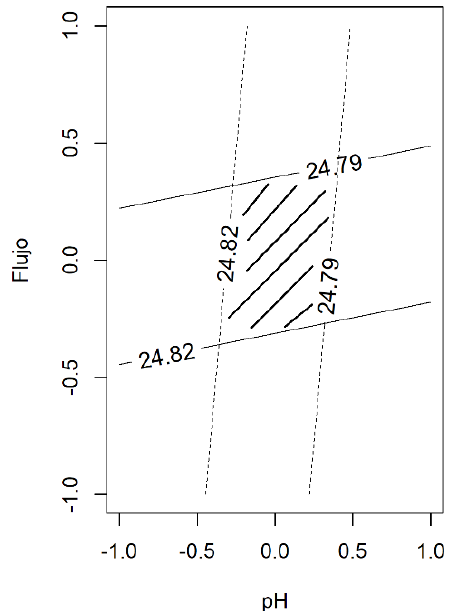
Figure 2. The contour plot of the monomer content obtained in the evaluation of robustness. The intersection of two variables (pH and Flow) allows for the defining of the space design (the underlined area).